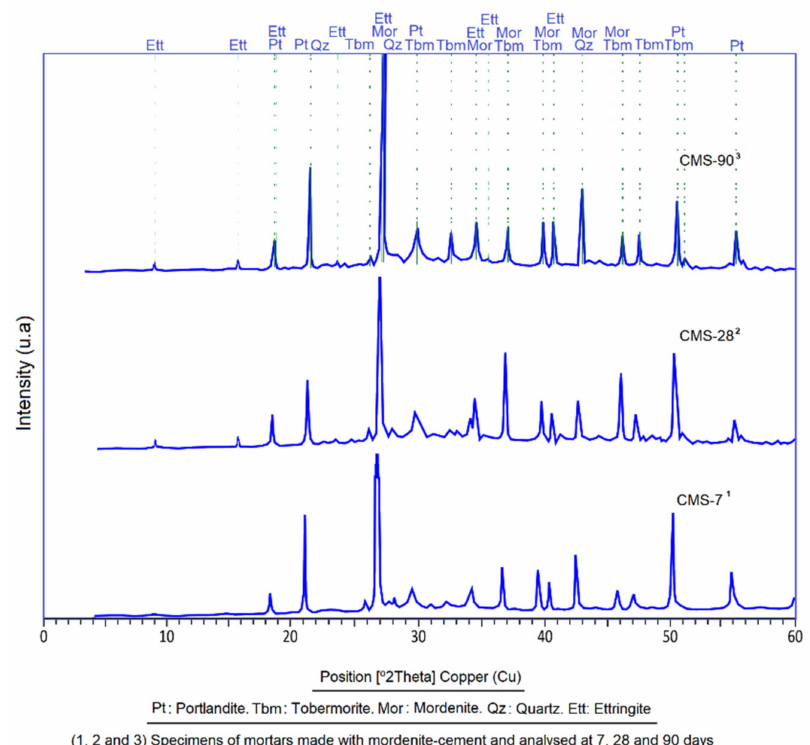
Figure 18. X-ray diffraction patterns showing the evolution in time of the mineral phases found in